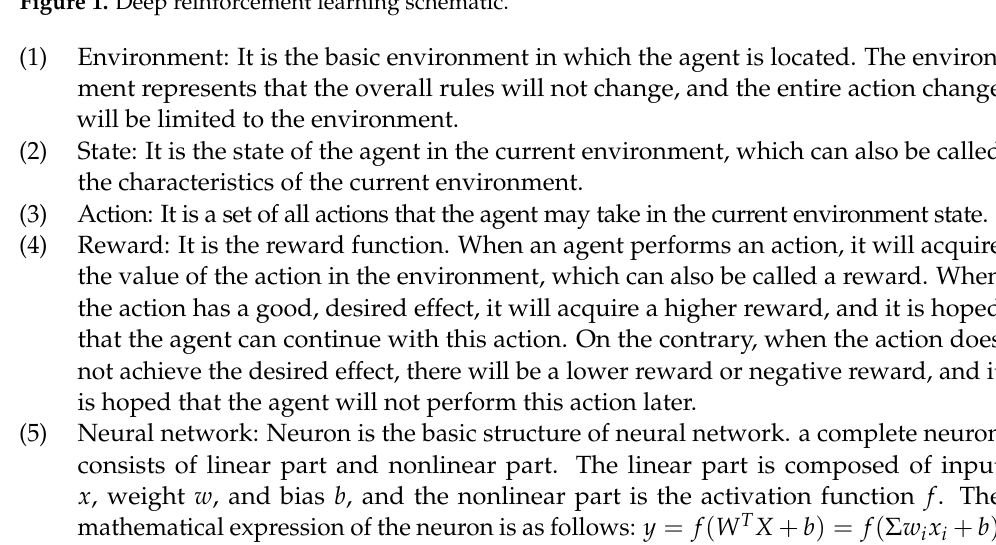
Figure 1. Deep reinforcement learning schematic.